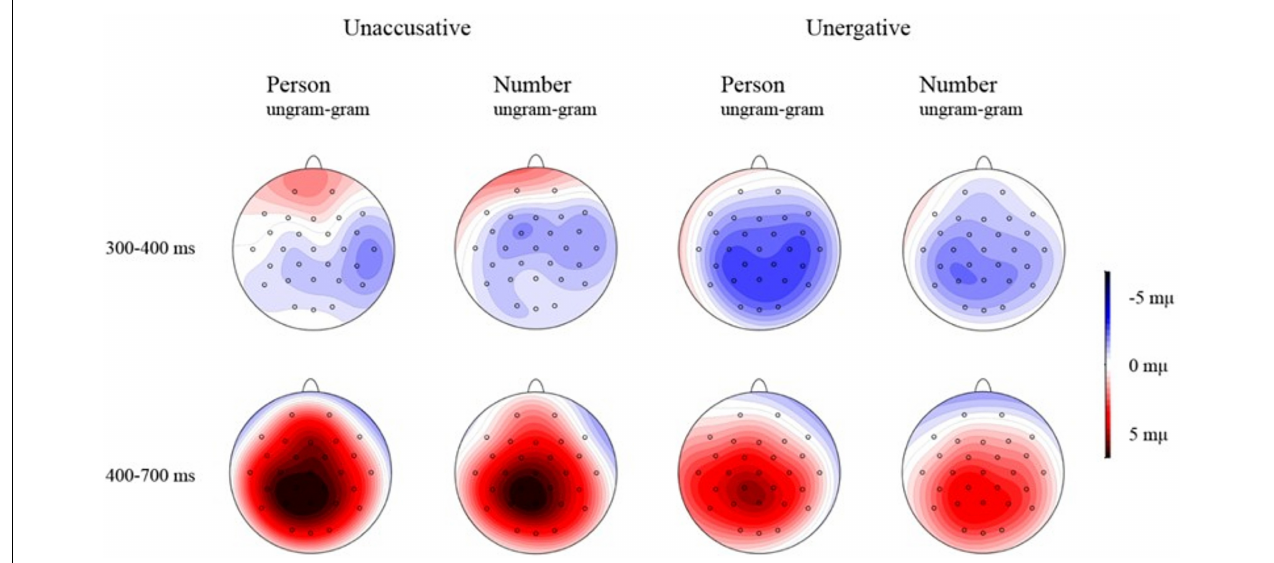
FIGURE 4 | Mean voltage difference maps (grammatical minus